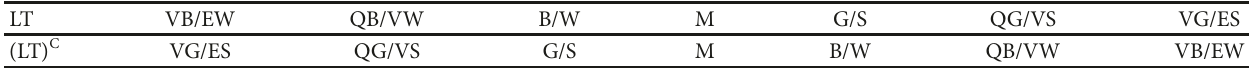
Table 2: The complementary relations [35, 37].